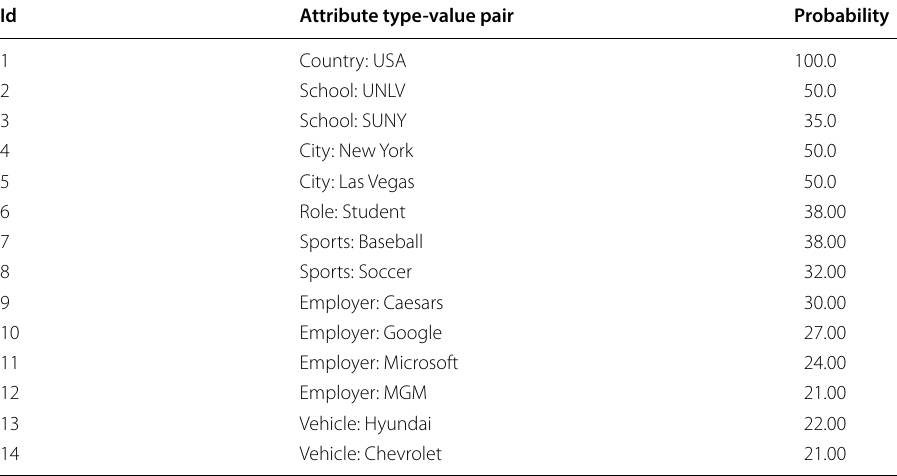
Table 3 Node-weight for Karate-club